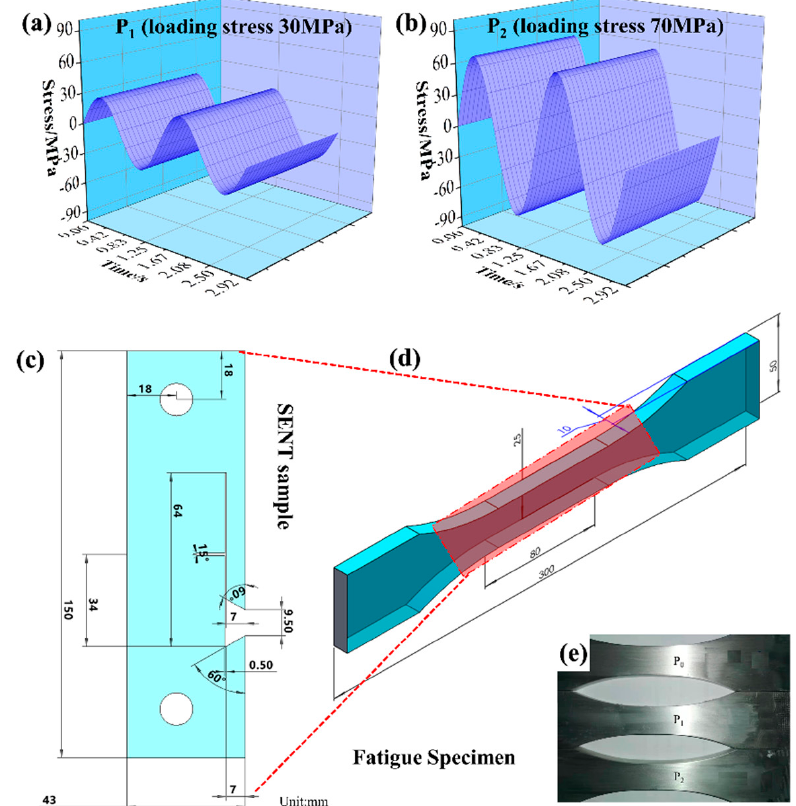
Figure 1. ( a ) P 1 (loading stress 30 MPa) fatigue cycle curve, ( b ) P 2 (loading stress 70 MPa) fatigue cycle curve, ( c ) dimension diagram of crack growth specimen (SENT specimen), ( d ) fatigue specification, ( e ) actual fatigue specimen. Table 1. Fatigue test parameters of A7N01P −− T4 aluminum alloy base